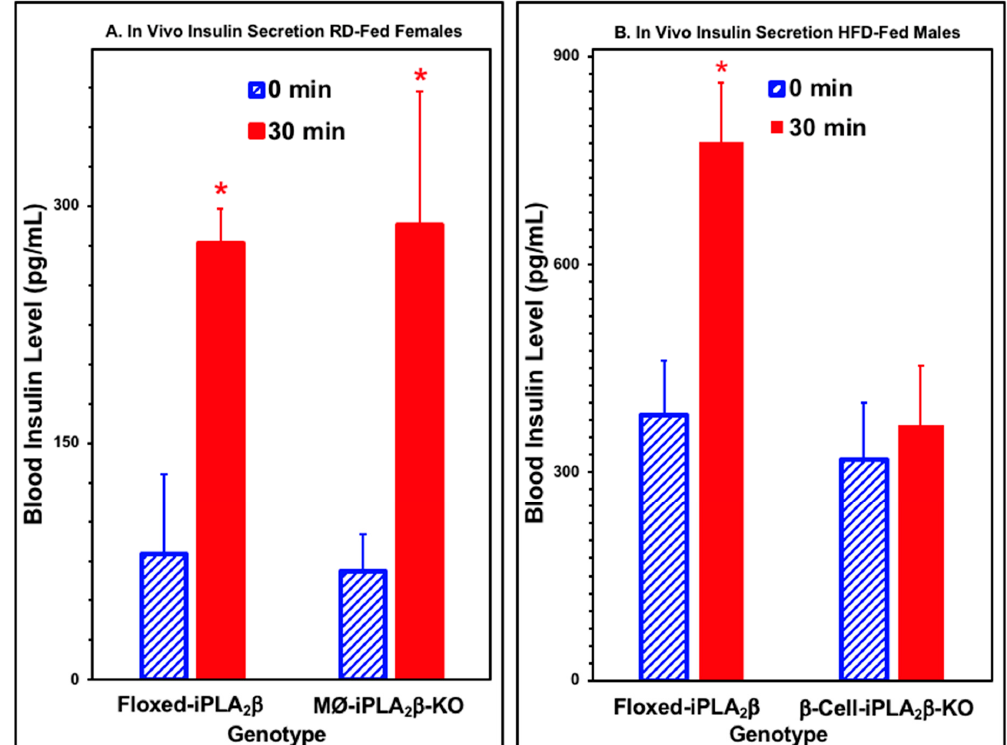
Figure 5. In vivo insulin secretion for iPLA 2 β conditional knockout mice and floxed-iPLA 2 β control mice fed a regular (RD) or high-fat diet (HFD). After an overnight fast, baseline blood samples were obtained from the saphenous vein of male ( A ) or female ( B ) MØ-iPLA 2 β -KO mice, β -cell-iPLA 2 β -KO mice, or floxed-iPLA 2 β control mice 6 months of age that had been fed a regular diet (RD, A ) or high-fat diet (HFD, B ). D -glucose (3 mg/kg body weight) was administered by intraperitoneal injection, and a blood sample was obtained 30 min thereafter. The insulin contents of the baseline and 30 min samples were then measured by enzyme-linked immunosorbent assay, as described [23,24,57]. Displayed values represent mean ± SEM. An asterisk (*) denotes p < 0.05 for the comparison between the time 0 and 30 min values (n = 5 to 28). In contrast, neither RD-fed female or HFD-fed male β -cell-iPLA 2 β -KO mice exhibited a significant increase in blood insulin levels 30 min after intraperitoneal glucose administration (Figure 5A,B and Figure S1). This is consistent with the impairment of ex vivo glucose-dependent insulin secretion that was observed with pancreatic islets isolated from β -cell-iPLA 2 β -KO mice relative to floxed-iPLA 2 β controls (Figure 4), suggesting that inadequate insulin secretion contributes to the substantially impaired glucose tolerance observed with β -cell-iPLA 2 β -KO mice (Figures 2 and 3).